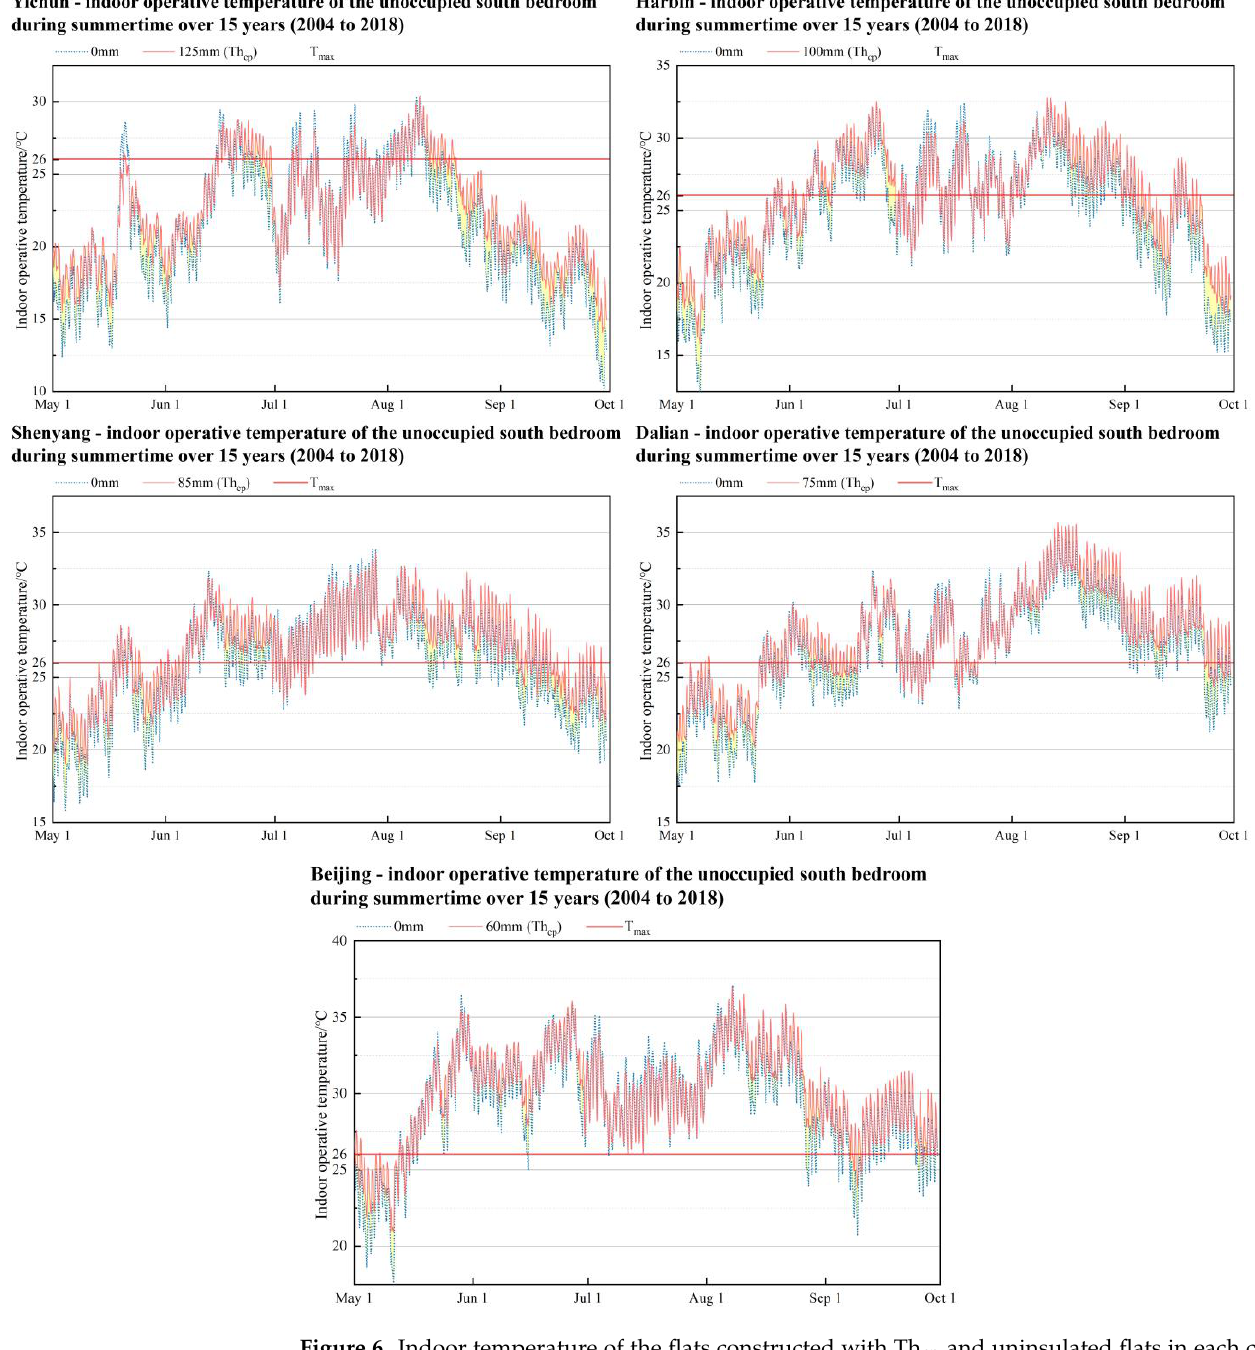
Figure 6. Indoor temperature of the flats constructed with Th cp and uninsulated flats in each city during the summertime over 15 years (2004 to 2018) (T max : the static temperature threshold from CIBSE Guide A; the periods when the indoor temperatures of uninsulated flats were lower than those of flats constructed with Th cp are denoted in yellow). Table 9. Overheating duration with Th insulation as variable in the simulated flats (on the 7th floor) of each representative city during summertime over 15 years (2004 to 2018).